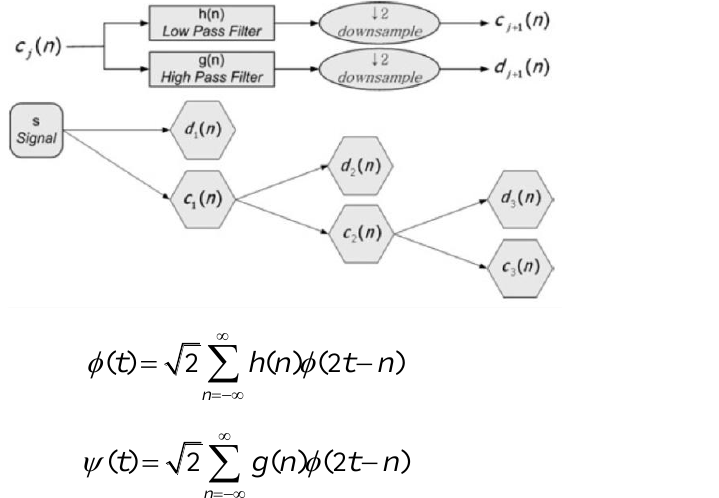
Figure 4. Signal decomposition using wavelet